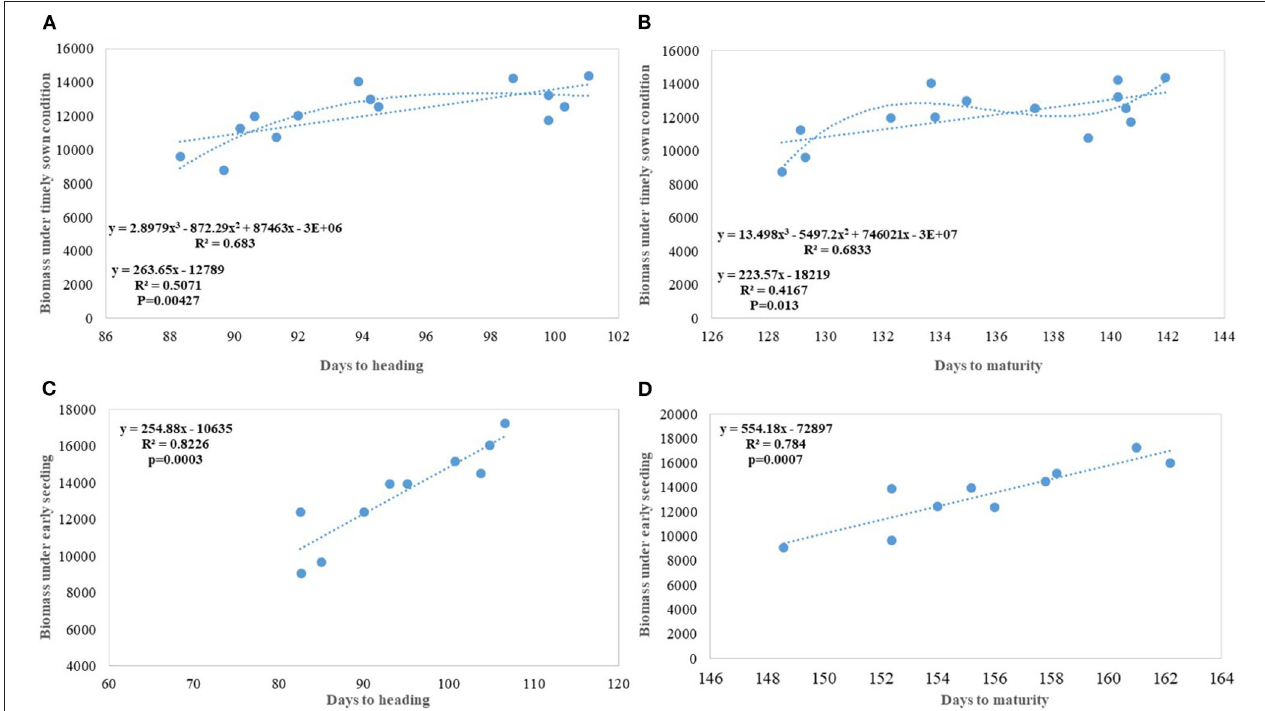
FIGURE 9 | Increase in biomass due to increased duration and delayed heading (A) Days to heading (DH) vs. biomass under timely sown condition; (B) Days to maturity vs. biomass under timely sown condition; (C) DH vs. biomass under early seeding; (D) Days to maturity vs. biomass under early